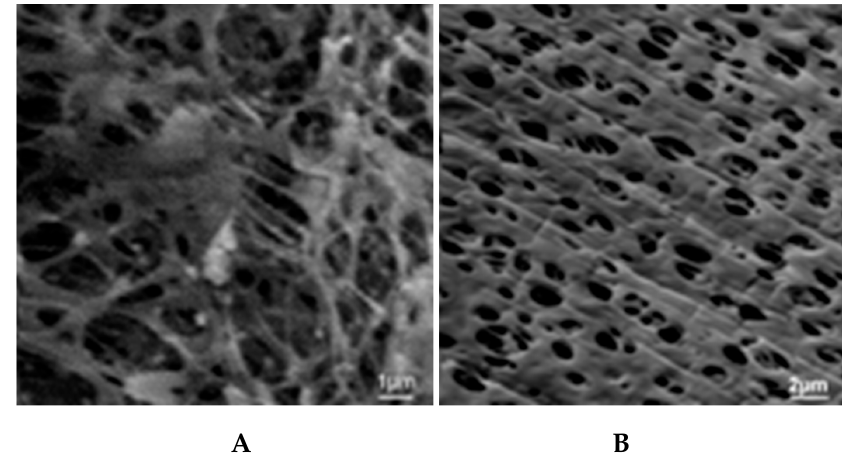
Figure 6. EM of the polysulfone (PSf) capillary ultrastructure: ( A ) EM of the sublayer voids (a sponge-like membrane area) in the dissected capillary wall; and ( B ) EM of the outer surface of PSf capillary (Electron microscopy: REMMA-101A, AO “SELMI”, accelerating voltage 20